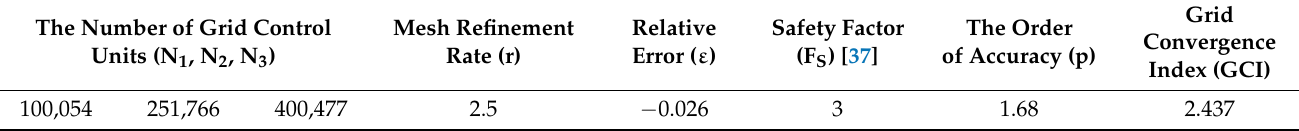
Figure 4. Fluid flow state in micromixer. ( a ) Experimental results; ( b ) Numerical results Experimental results of the micromixer in reference [38] are used to validate the com- putational model and numerical results. A 3D micromixer model with the same structure in [38] is set up and the results of the concentration field in the mid − section at Re = 0.5, 1, 5, 15, 25, 40, 50, 80 are presented in Figure 5, which shows the numerical results of the mixing index obtained by the computational model in this paper, and the experimental